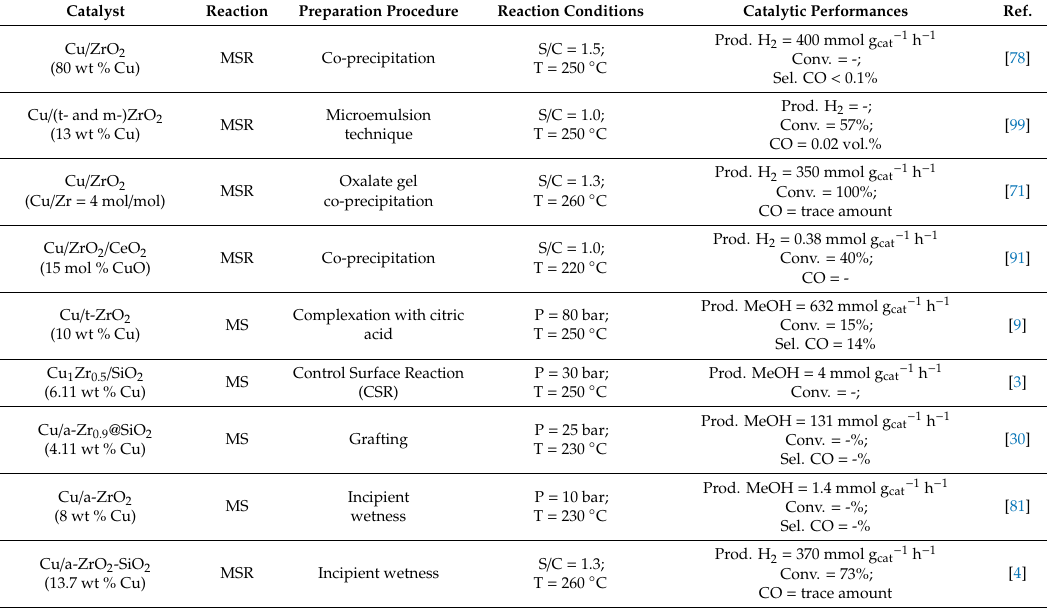
Table 1. Comparison between the catalytic behavior for the copper–zirconia catalysts reported in this review in methanol synthesis (MS) and methanol steam reforming (MSR)